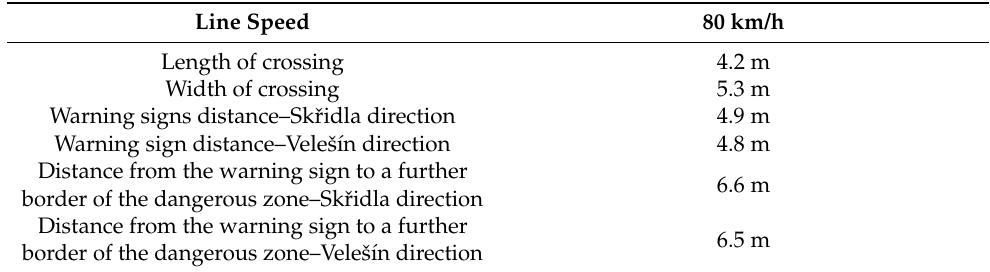
Table 6. Basic parameters of Crossing No.